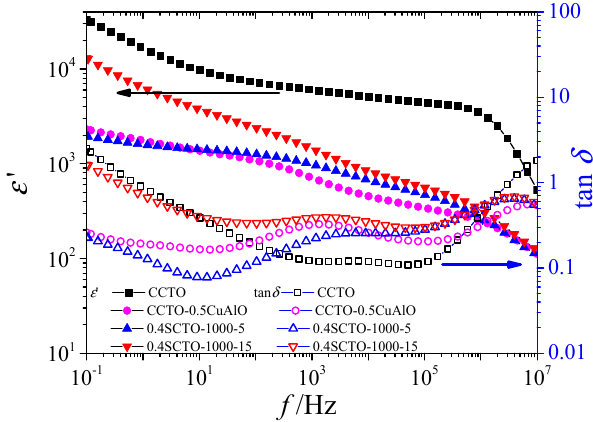
Figure 4. Dielectric performance at room temperature of CCTO, CCTO-0.5CuAl 2 O 4 , and 0.4SCTO-0.6CCTO ceramics.